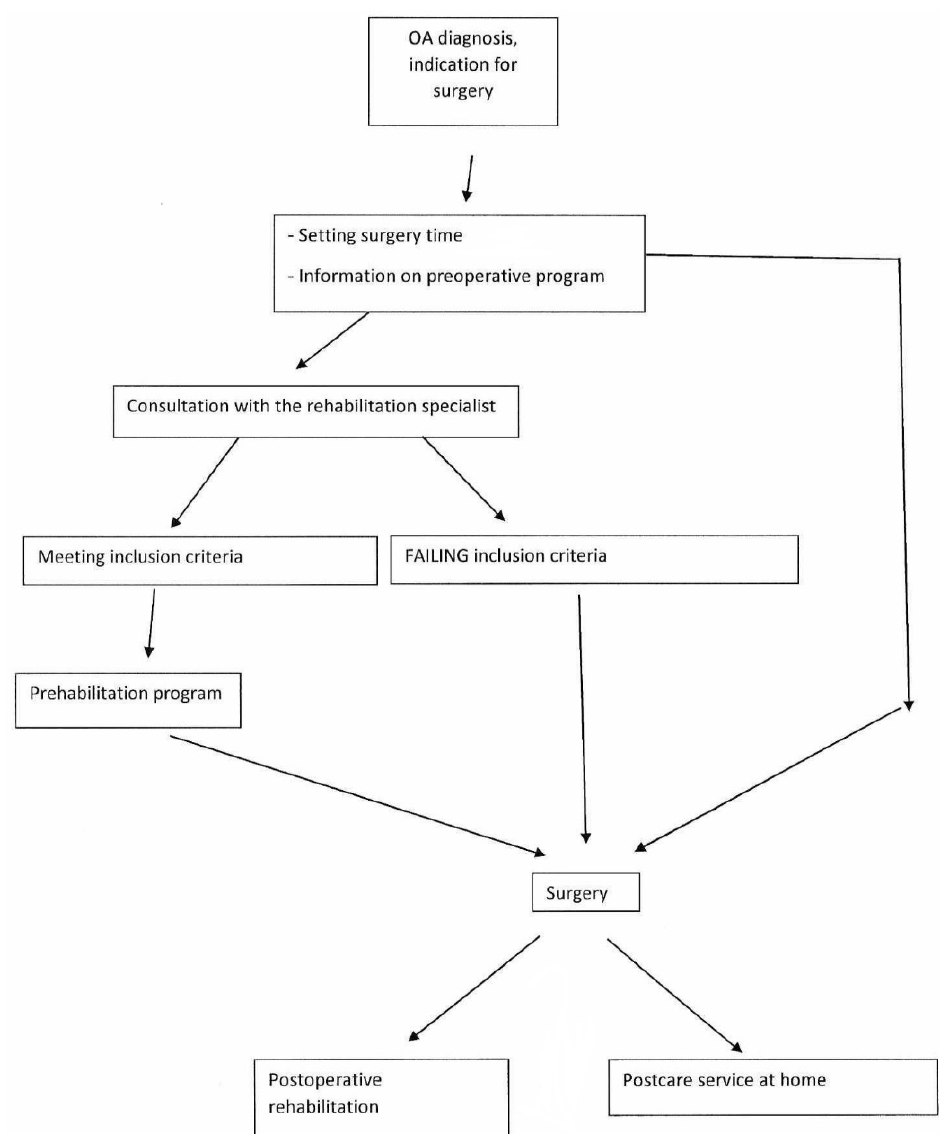
Figure 1. Flow chart showing the recruitment of